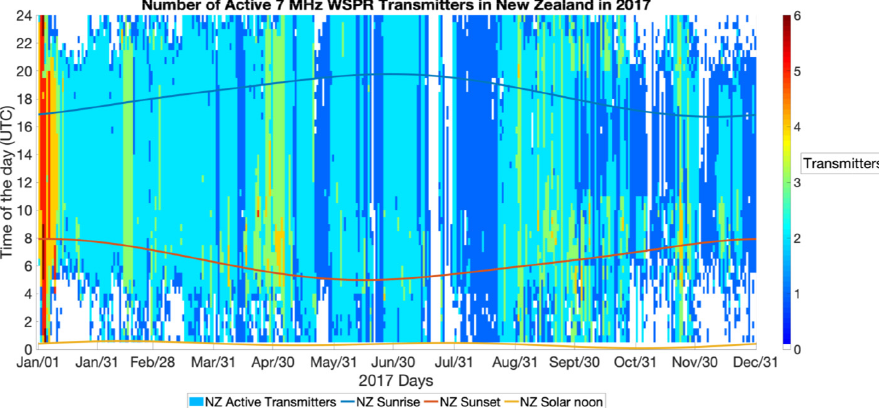
Figure 8. Number of active New Zealand WSPR transmitters in 2017. Only transmitters with a proven capability to cover the distance from New Zealand to the UK are shown. The colours indicate the number of transmitters available in each half-hour interval.